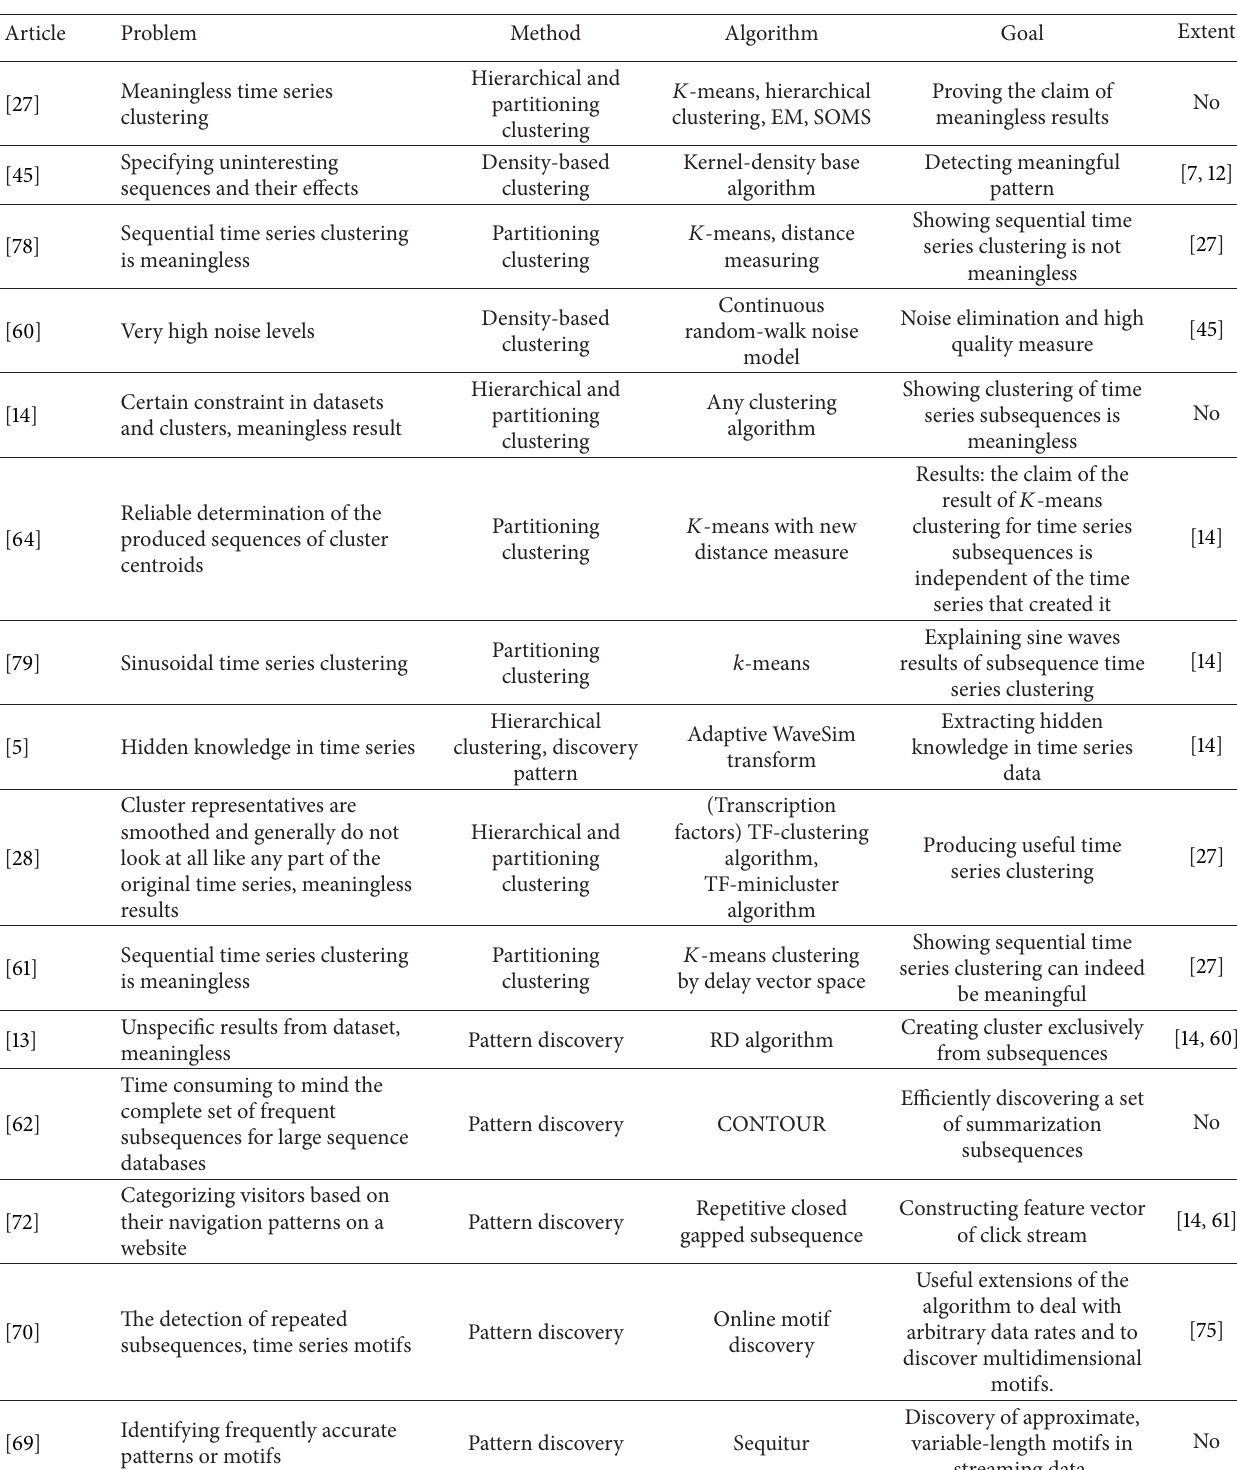
Table 2: The overview of interproof period